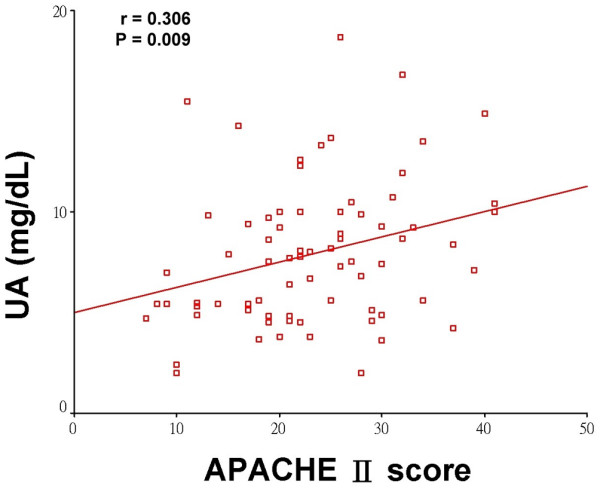
Correlation between serum UA and APACHE II score in patients with severe sepsis. A total of 73 patients were included in the study. APACHE, Acute Physiology and Chronic Health Evaluation; UA, uric acid.